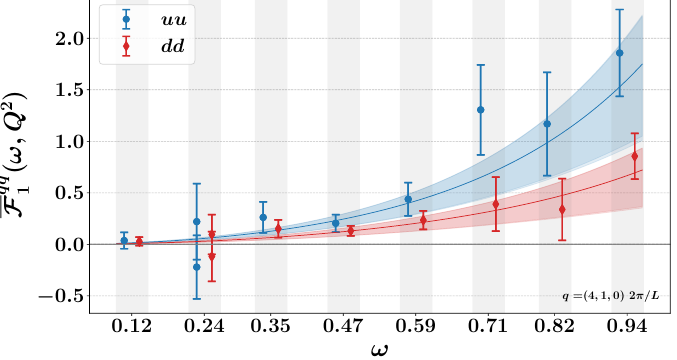
( ω , Q 2 ) for Q 2 = 4.7GeV 2 . The blue circles are for J ( u ) Figure 4: ω dependence of F 1 the red diamonds for J ( d ) . The fits, blue and red lines with errors given by shaded z region are described in the text. The points are slightly shifted for